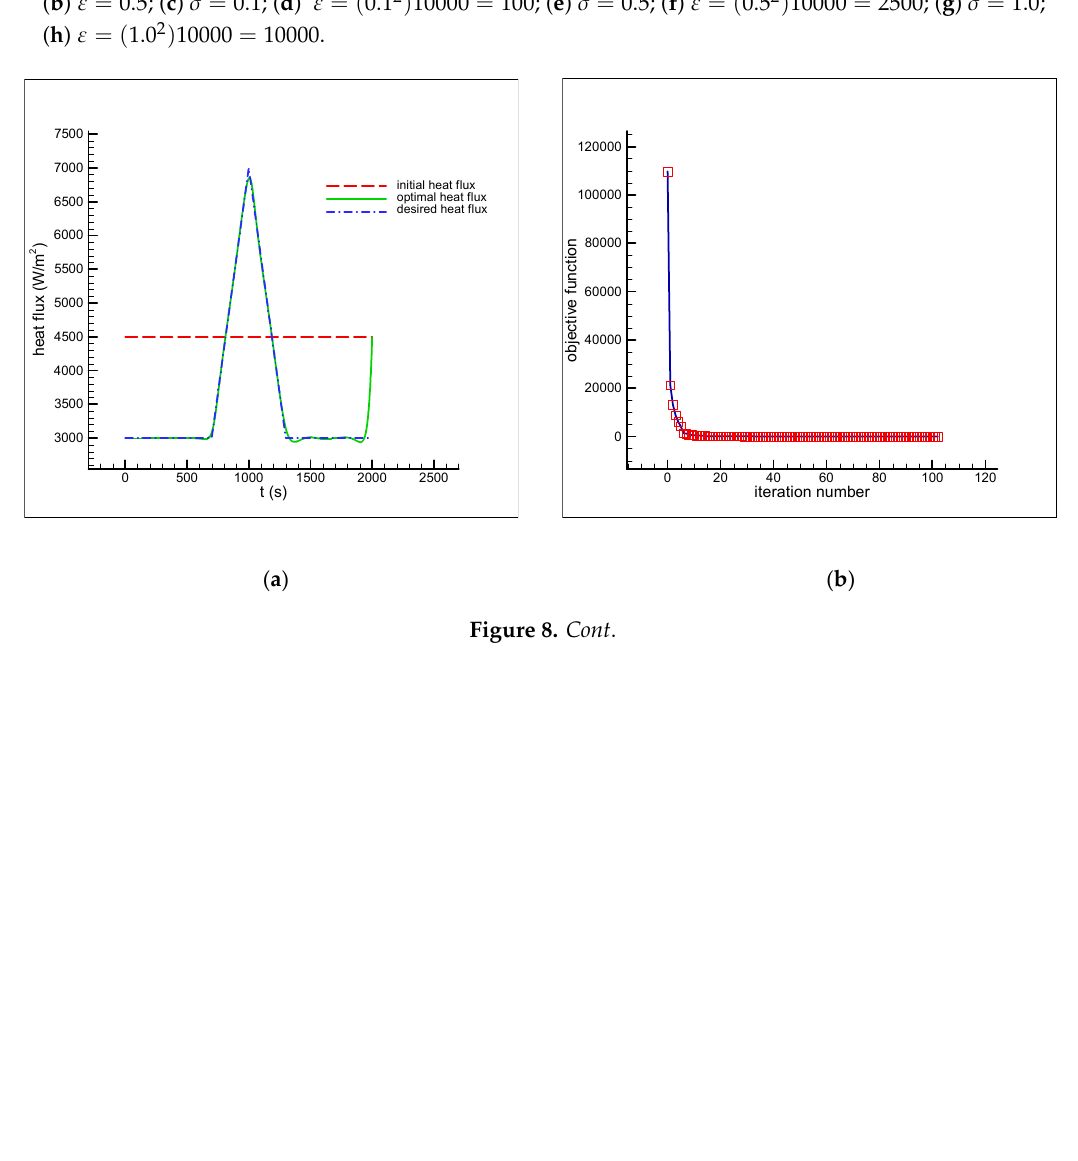
Figure 7. Estimation of the timewise varying heat flux q using an initial guess sinusoidal and objective function versus iteration number (Test case 2) for cases of no measurement error ( a , b ) and measurement error of σ = 0.1 ( c , d ), σ = 0.5 ( e , f ), and σ = 1.0 ( g , h ). ( a ) σ = 0.0; ( b ) ε = 0.5; ( c ) σ = 0.1; ( d ) ε = ( 0.1 2 ) 10000 = 100; ( e ) σ = 0.5; ( f ) ε = ( 0.5 2 ) 10000 = 2500; ( g ) σ = 1.0; ( h ) ε = ( 1.0 2 ) 10000 = 10000.